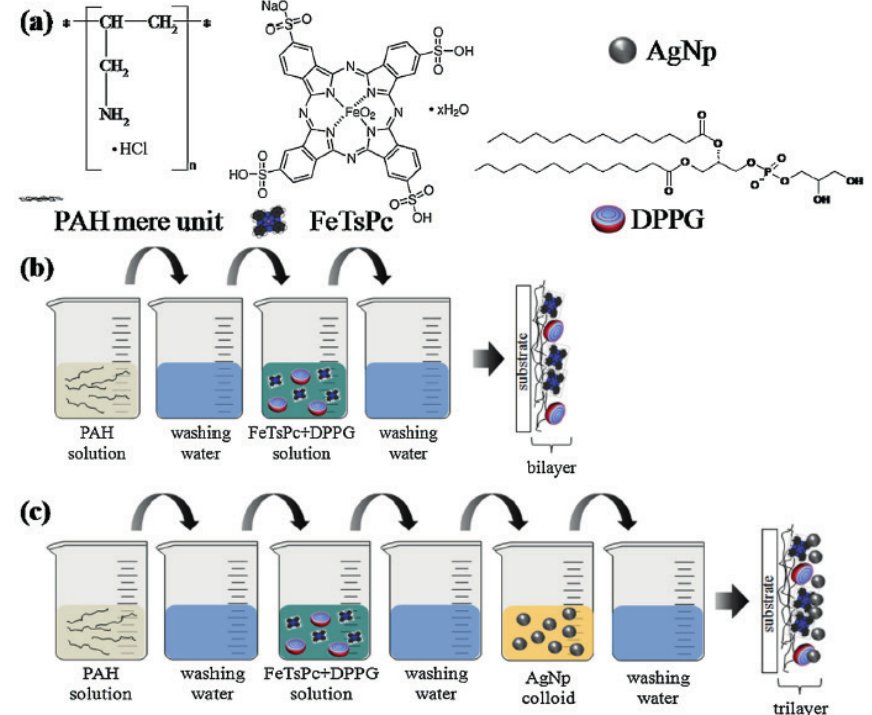
Figure 4 - Schemes of PAh (mere), FeTsPc and DPPG molecular structures as well as the LbL fi lms deposition through the formation of an assembly of bi and tri-layers. Adapted with permission (Alessio et al.